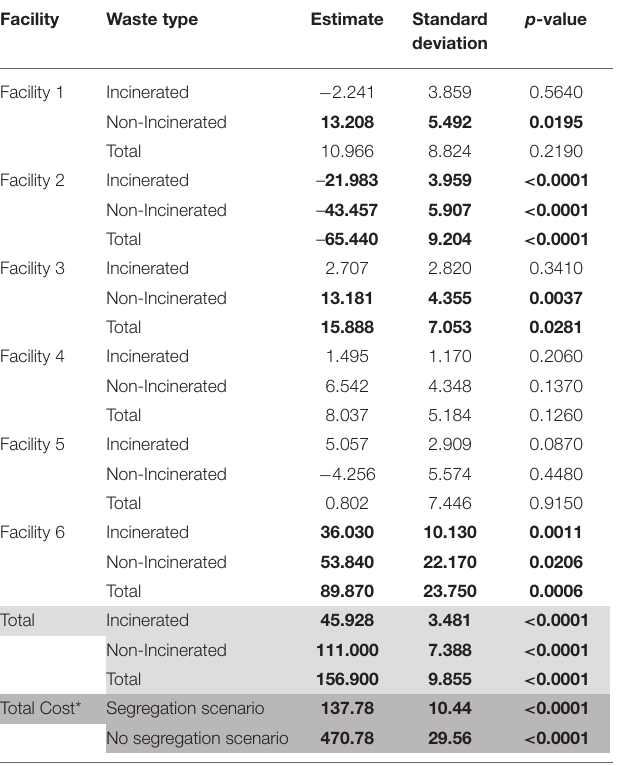
TABLE 2 | Estimates of the change in the amount of incinerated and non-incinerated waste (kg) produced in each facility of the medical facility per month and p -value of the stationarity test.